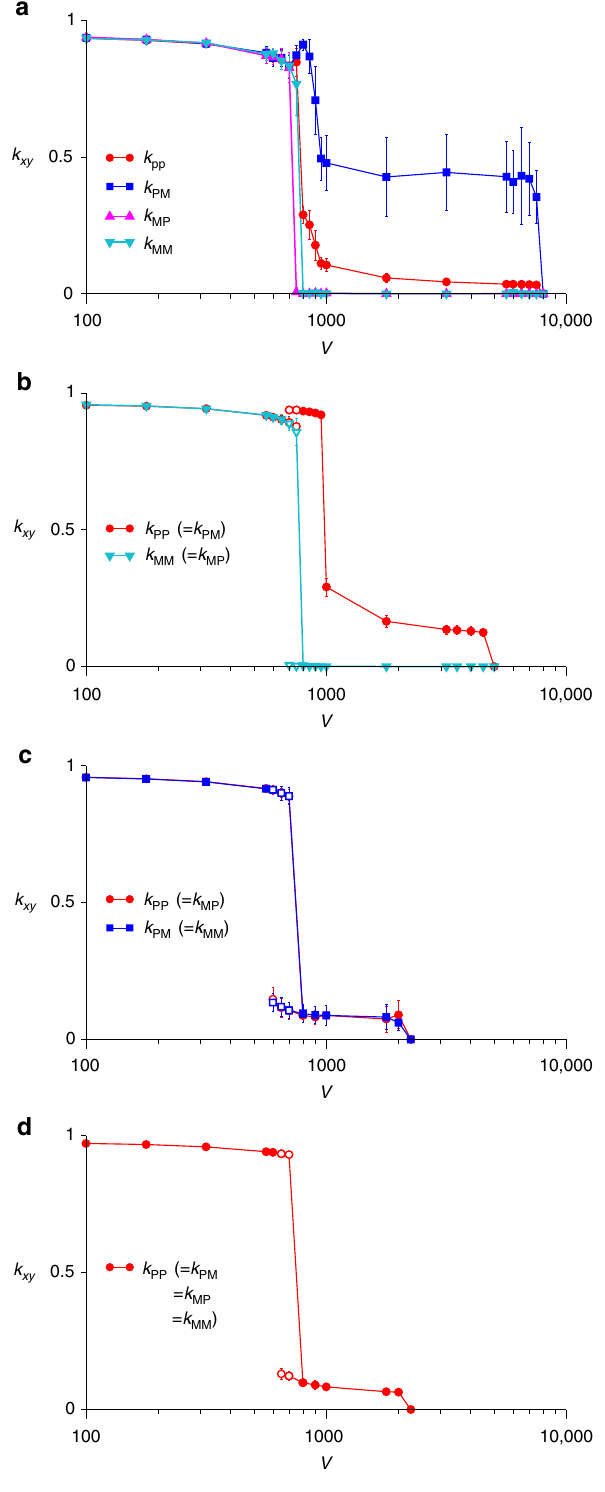
Fig. 2 Equilibrium average catalytic activities ( k xy ) as functions of cell size ( V ). The values of k xy were fi rst averaged over all replicators at each time point. Then, the average (symbols) and s.d. (error bars) of k xy overtime were calculated after equilibration. The open symbols indicate metastable states (i.e., states reachable from different initial conditions with no state transition observed within 10 7 time steps; a replicator decays approximately with a probability d per time step). For visibility, the non-catalytic strand (if it evolves) was assumed to be always the minus strand. Parameters: m = 0.01, d = 0.02, N = 50 V . a . The full model (no symmetry imposed). b . The model in which kinetic symmetry is imposed (i.e., k PP = k PM and k MP = k MM ). c . The model in which functional symmetry is imposed (i.e., k PP = k MP and k PM = k MM ). d . The model in which both kinetic and functional symmetry are imposed (i.e., k PP = k PM = k MP = k MM